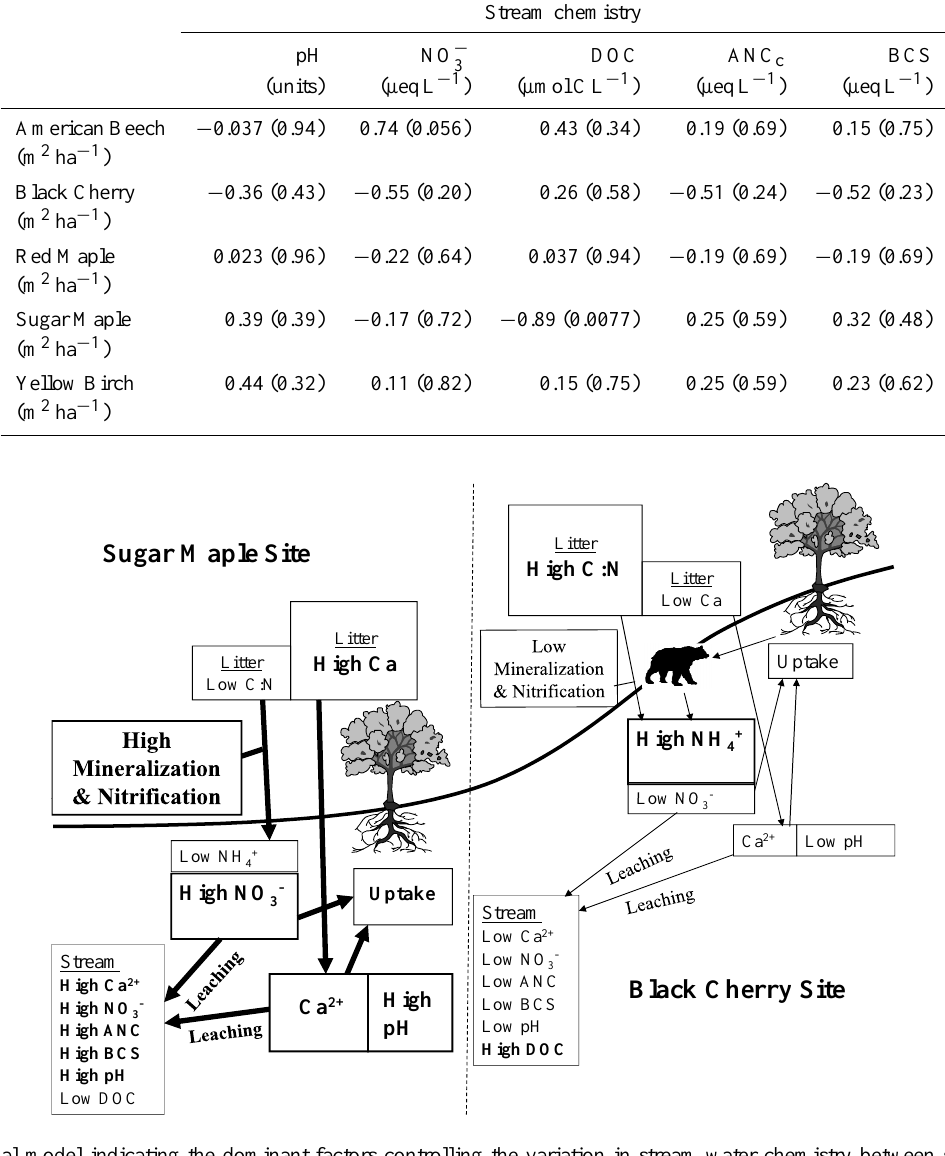
Fig. 6. Conceptual model indicating the dominant factors controlling the variation in stream water chemistry between sites with similar atmospheric deposition and land use but varying tree species and soil processes in a northern hardwood dominated ecosystem. Thicker arrows indicate relatively greater fluxes and larger boxes indicate relatively larger pools between